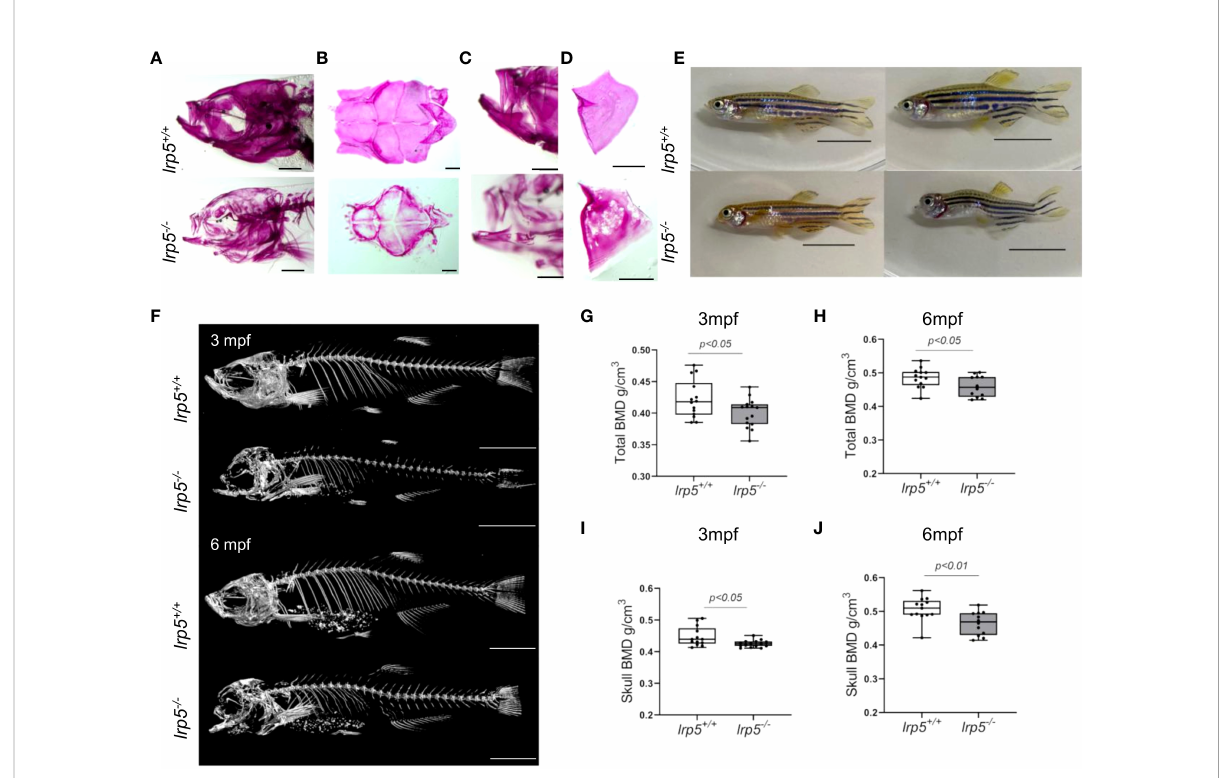
FIGURE 2 lrp5 -/- adult fi sh display low bone mineral density. (A) Whole-mount alizarin red staining at 1.5 mpf display the distribution of mineralized matrix through the head bones. In the skull of lrp5 -/- distribution of mineralized matrix throughout whole head bones differs from lrp5 +/+ Scale bar=1mm. (B) coronal view of the cranial vault. The alizarin red signal is distributed ubiquitously in lrp5 +/+ lower jaw (C) and opercle (D) , meanwhile in lrp5 -/- fi sh the lower jaw demonstrated discontinues alizarin red signal. Scale bar=500µm. (E) Representative photos of lrp5 +/+ and lrp5 -/- siblings at 4mpf; lrp5 -/- present with deformed head and body curvatures. Scale bar=1cm. (F) 3D reconstruction of X-ray images of lrp5 +/+ and lrp5 -/ - skeleton at 3 and 6mpf. Scale bar= 1cm (G, H) Total BMD is decreased in adult lrp5 -/- fi sh. (I, J) the skull BMD of lrp5 -/- mutant fi sh is signi fi cantly lower both at 3 and 6mpf. Results in G-J are expressed as mean SD (3mpf n =13-15 fi sh, 6mpf n =12-13 fi sh,